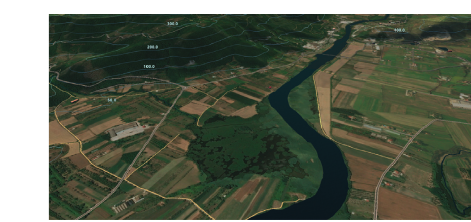
Figure 4: Infraworks digital terrain